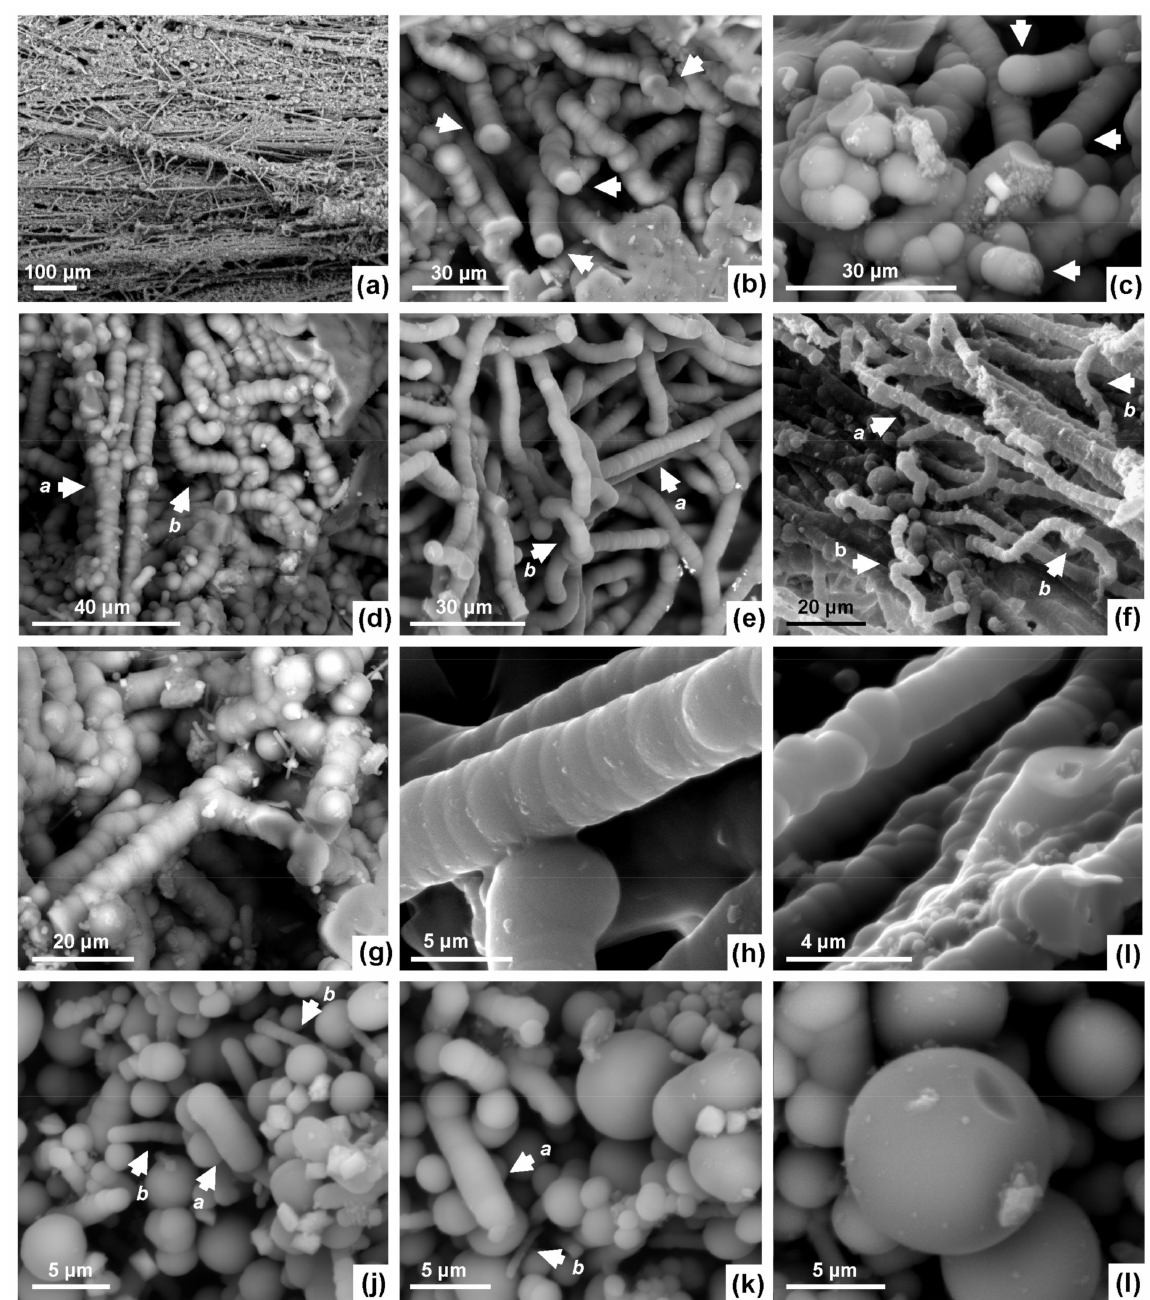
Figure 8. ESEM images of silicified microbes from the Selt ú n sinter. ( a ) Straight filaments with bimodal diameter sizes (peaks at 5 and 20 µ m) forming a wavy laminated fabric. ( b ) Coiled and contorted filaments with arrowed flat ends ( Calothrix morph). ( c ) Coiled and contorted filaments with arrowed thicker cap ends ( Phormidium morph). ( d – f ) Microbial meshworks of septate filaments with straight and bifurcating ( a ) vs twisted and spiral ( b ) shapes. ( g ) Filamentous-forming T-shaped branching filaments. ( h ) Superposed filaments mimicking branching. ( i ) Cross-section of a filament showing central lumen. ( j , k ) Clusters of filamentous, barrel-shaped to short filaments ( Fischerella morphs) with bimodal length/diameter ratio distribution (peaks at 3:1 and 8.5–9:1) mixed with opal-A spheres and jarosite crystals; barrel-sh. ( l ) Single opal-A sphere with lateral indentation reflecting the setting of an inner